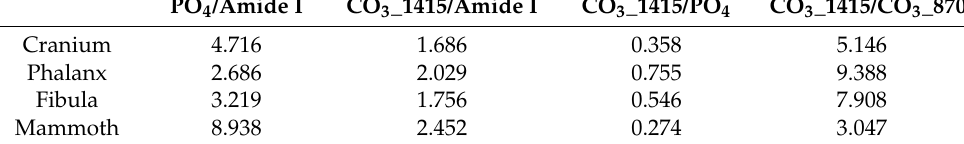
SEM images of mammoth samples (Figure 5) show a cortical bone section, with vas- cular canals filled by some bone fragments accompanied by pyrite (FeS 2 ) framboids of size ~15 µm, although this phase could not be detected by XRD. EDS analyses show relative percentages of Ca and P corresponding to apatite mineral composition (EDS analysis 2), and Fe and S elements corresponding to diagenetic pyrite presence (EDS analysis 1).